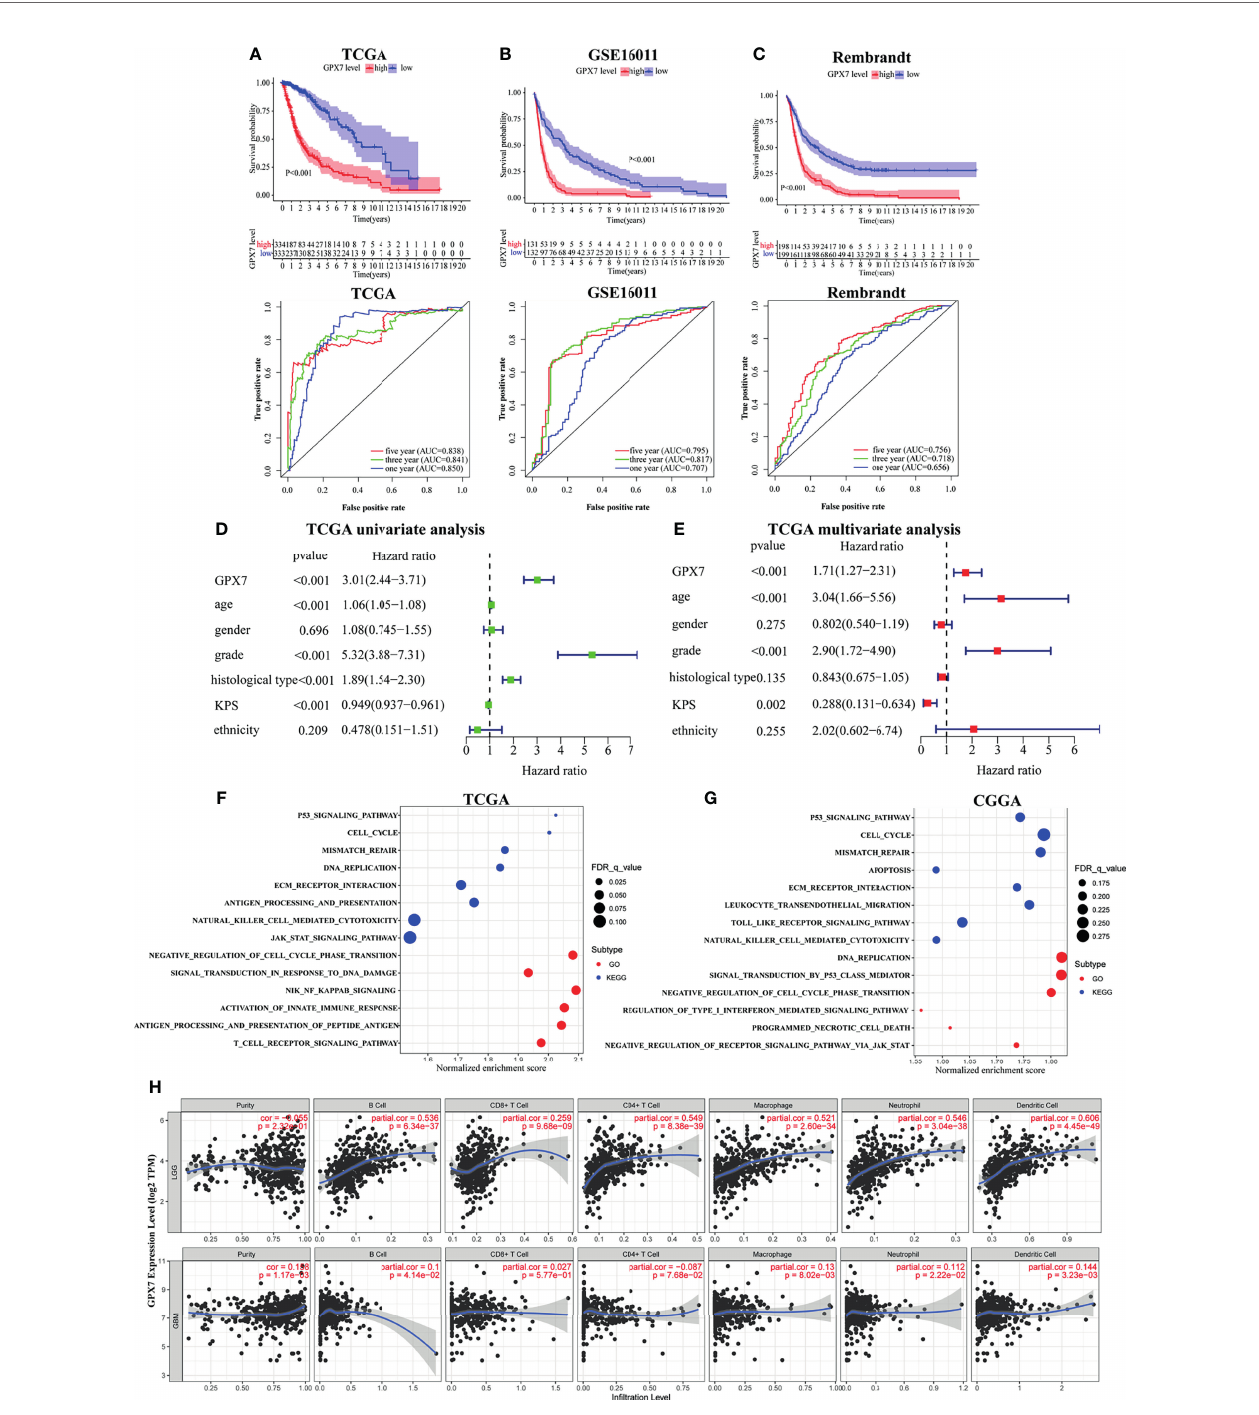
FIGURE 2 | The prognostic values of GPX7 in public databases and GSEA. (A – C) Kaplan – Meier analysis and 1, 3 and 5- year ROC curves of survival. (D, E) Univariate and multivariate Cox regression in TCGA. (F, G) GO and KEGG enrichment analyses using GSEA method in TCGA and CGGA. (H) The correlation between GPX7 and immune in fi ltration in LGG and GBM using the TIMER